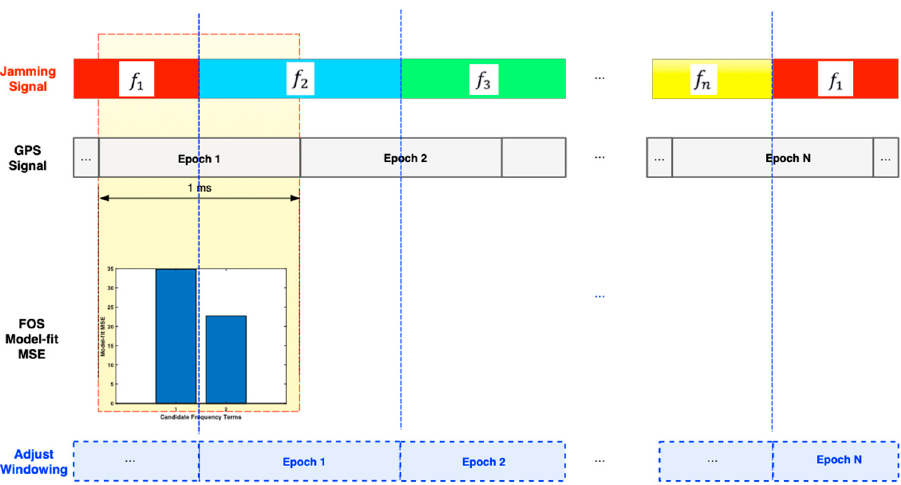
Figure 2. Adequate synchronization procedure using FOS.